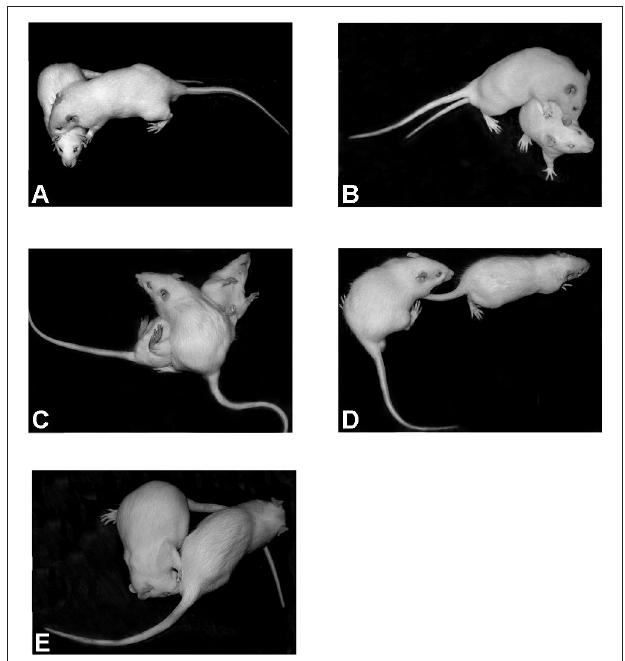
FIGURE 2 | Social behavioral patterns displayed by rats in a resident-intruder paradigm . (A) pouncing, (B) wrestling, (C) pinning, (D) following, and (E) genital